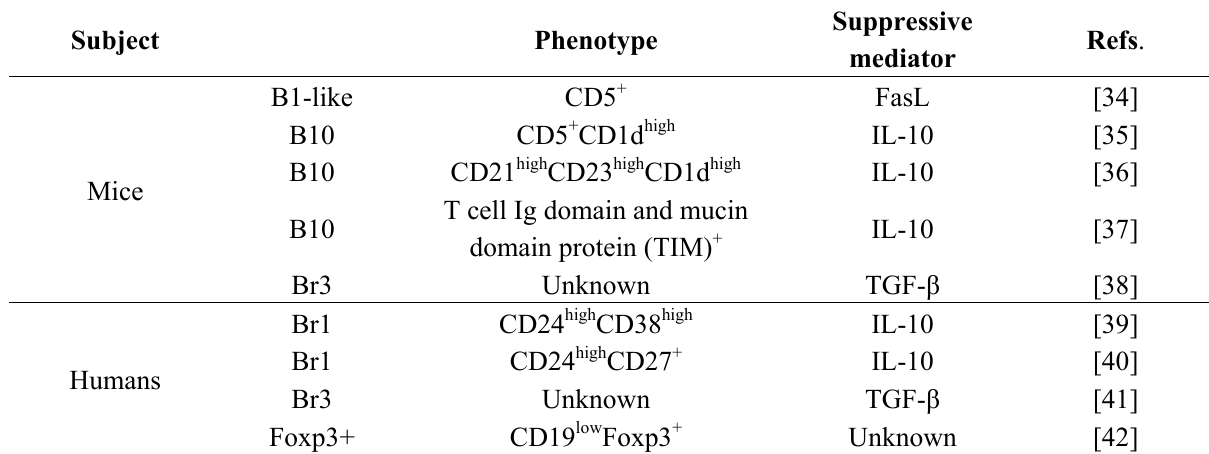
Table 1. Comparison between different regulatory B-cell (Breg) subsets and mechanism of